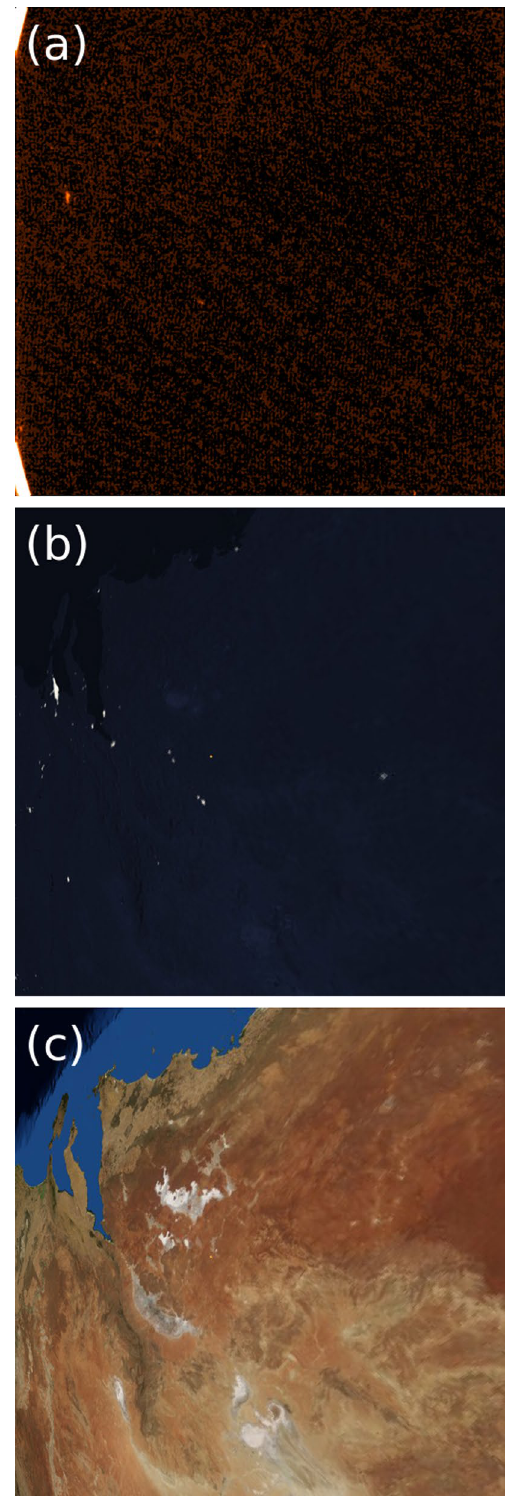
Fig. 14 a Australia imaged by ONC-W2 at 02:29 a.m. on December 6, 2020 (2 min before closest approach to Earth). The bright spot on the left of the image comes from the city lights of Adelaide. b Simulated night view of an ONC-W2 image at the same time. c Simulated image with the topography